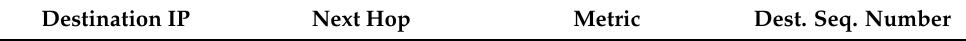
Table 3. Routing table for ClassA (Proactive).